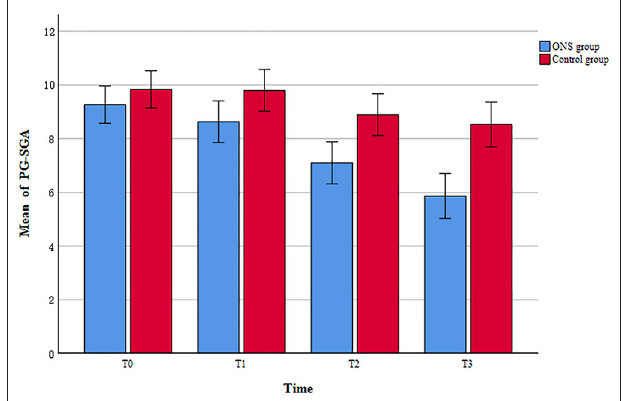
FIGURE 2 | The change of patient-generated subjective global assessment (PG-SGA) scores between ONS and control